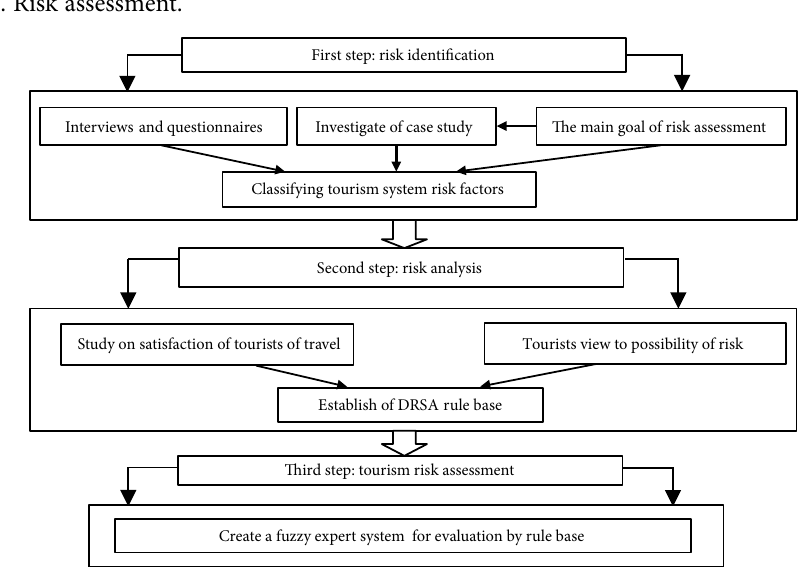
Fig. 5. Flowchart of proposed model to evaluate risks in tourist destination